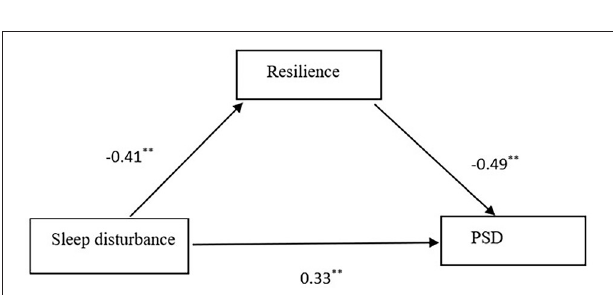
FIGURE 4 | Standardized solutions for the structural equation model of resilience, sleep disturbance, and PSD. **Indicating the coefficient of the path is